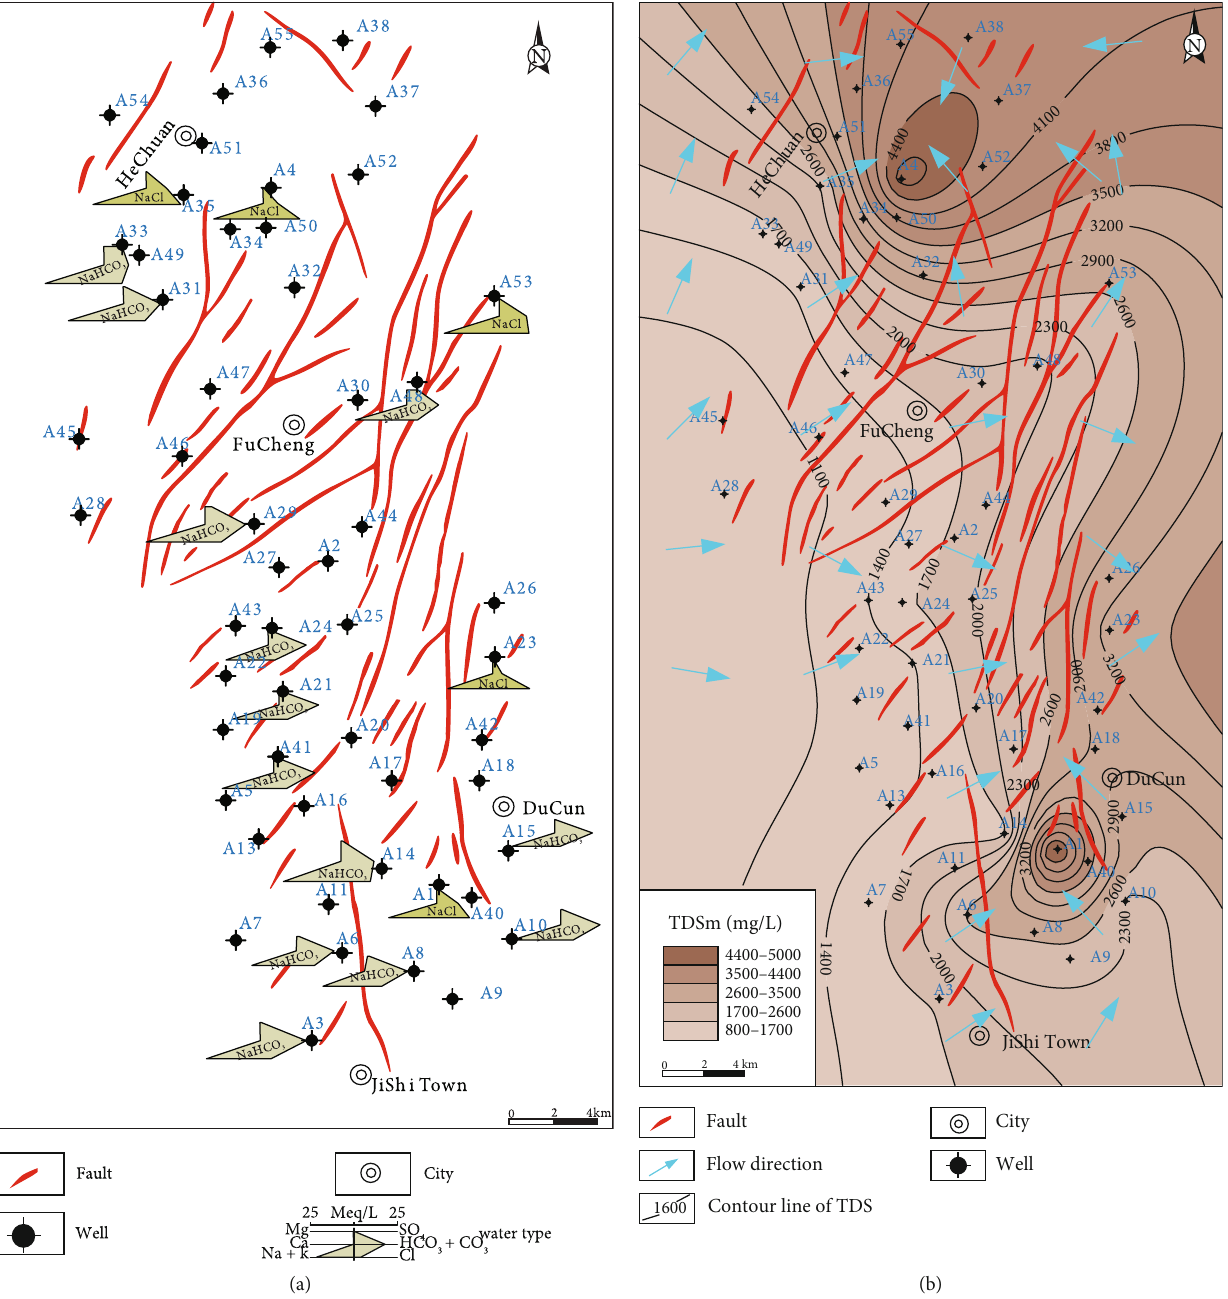
Figure 7: Distribution of groundwater chemical in Anze Bock. (a) Diagram of groundwater type in Anze Block and (b) diagram of groundwater TDS and fl ow direction in Anze